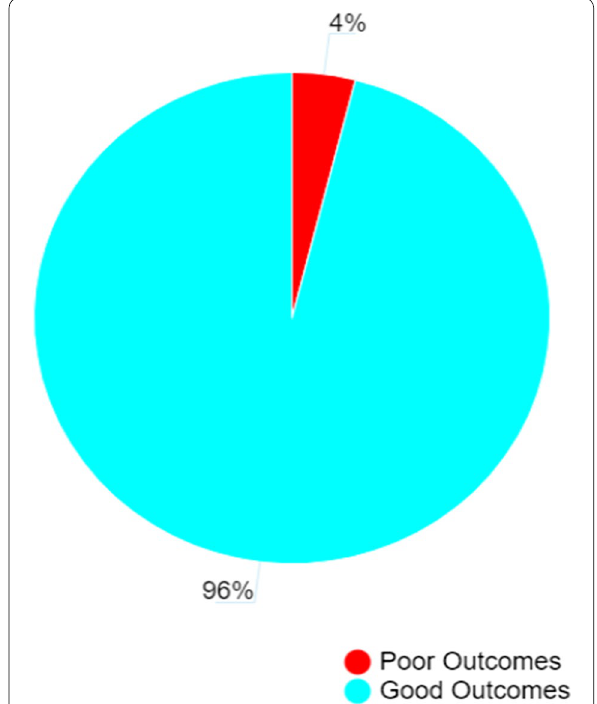
Fig. 2 Treatment outcomes of COVID‑19 patients managed under home‑based care in Kapelebyong district in eastern Uganda